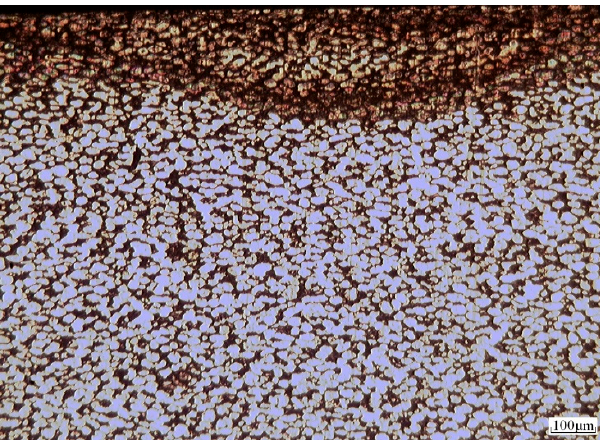
Figure 4. Metallographic of the quenched layer (magnification: 100).